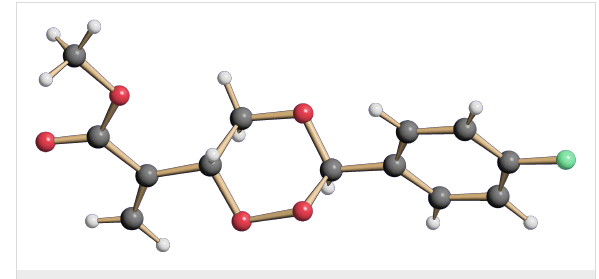
Figure 3: Structure of the 3-arylated trioxane 10b in the crystal.